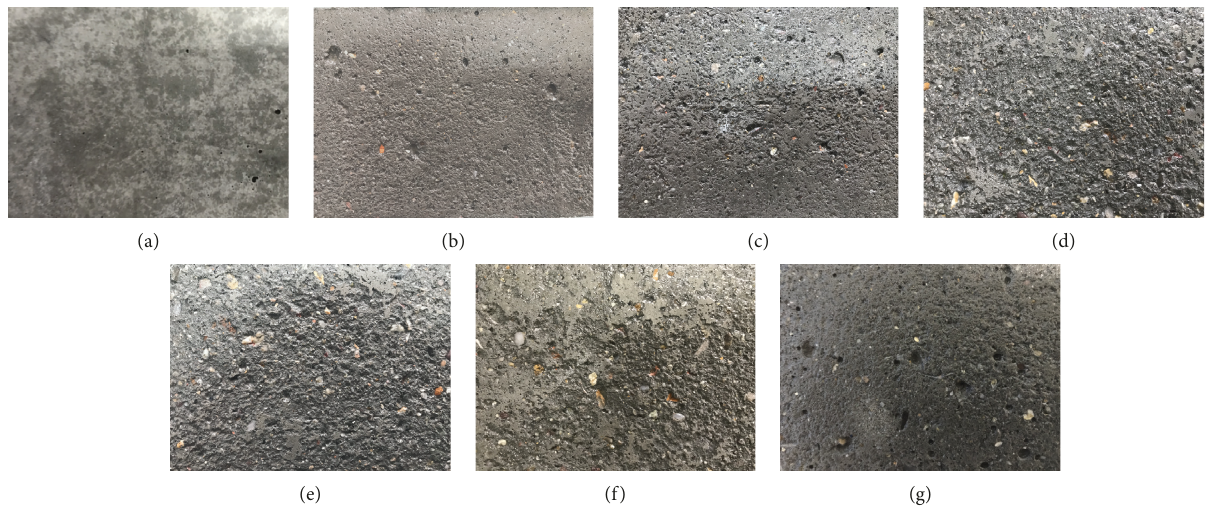
Figure 3: A2 surface damage: (a) A2-FC 0 cycles; (b) A2-FC 50 cycles; (c) A2-FC 100 cycles; (d) A2-FC 150 cycles; (e) A2-FC 200 cycles; (f) A2-CF 200 cycles; (g) A2-F 200